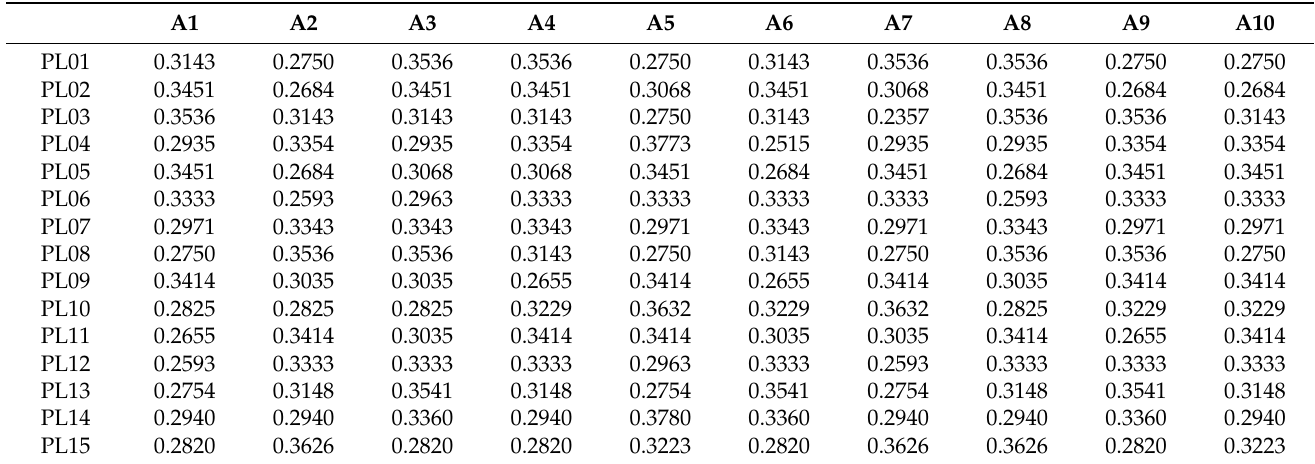
Table 3. Normalized matrix.